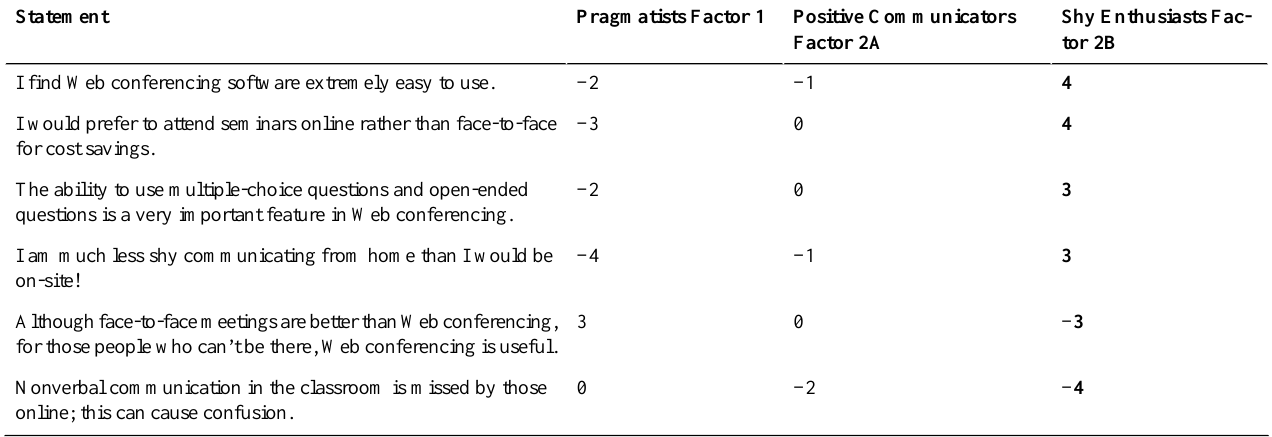
Table 4. Factor 2B scores for distinguishing statements for shy enthusiasts (n = 4)*